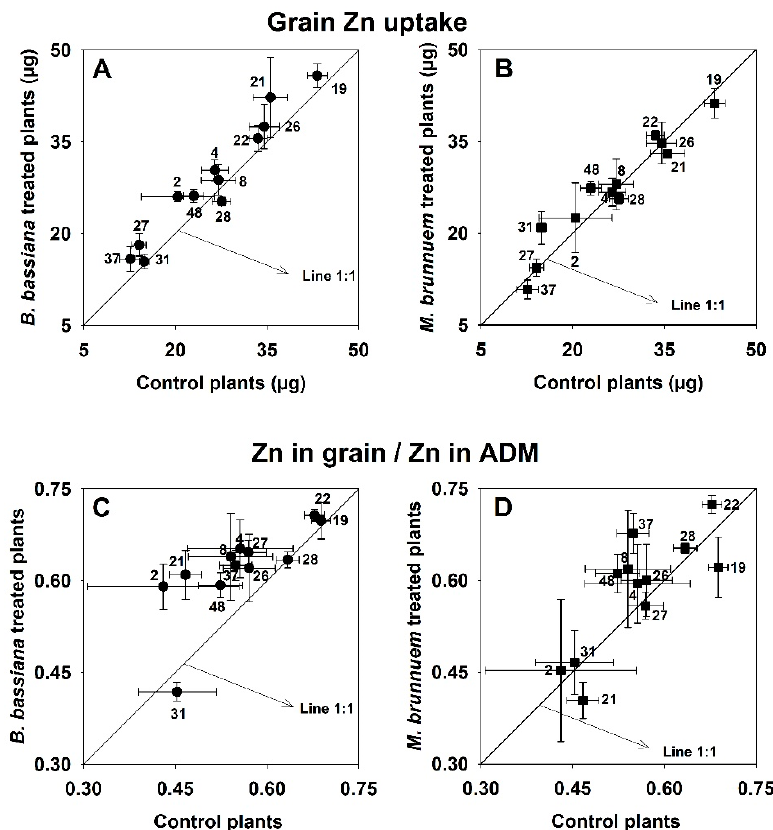
Figure 2. Grain Zn uptake (µg plant − 1 ) and proportion of Zn in grain relative to that in aerial dry matter (mean ± SE, n = 6) of durum wheat plants inoculated with B. bassiana ( A and C , respectively) and M. brunneum ( B and D , respectively) relative to the Control plants at harvest. The numbers by the symbols are the soil codes. The 1:1 line represents the mean value of the Control treatment for each soil, the horizontal error bars of the spots correspond to the standard errors for non-inoculated plants and the vertical bars to those for the fungus-treated plants.